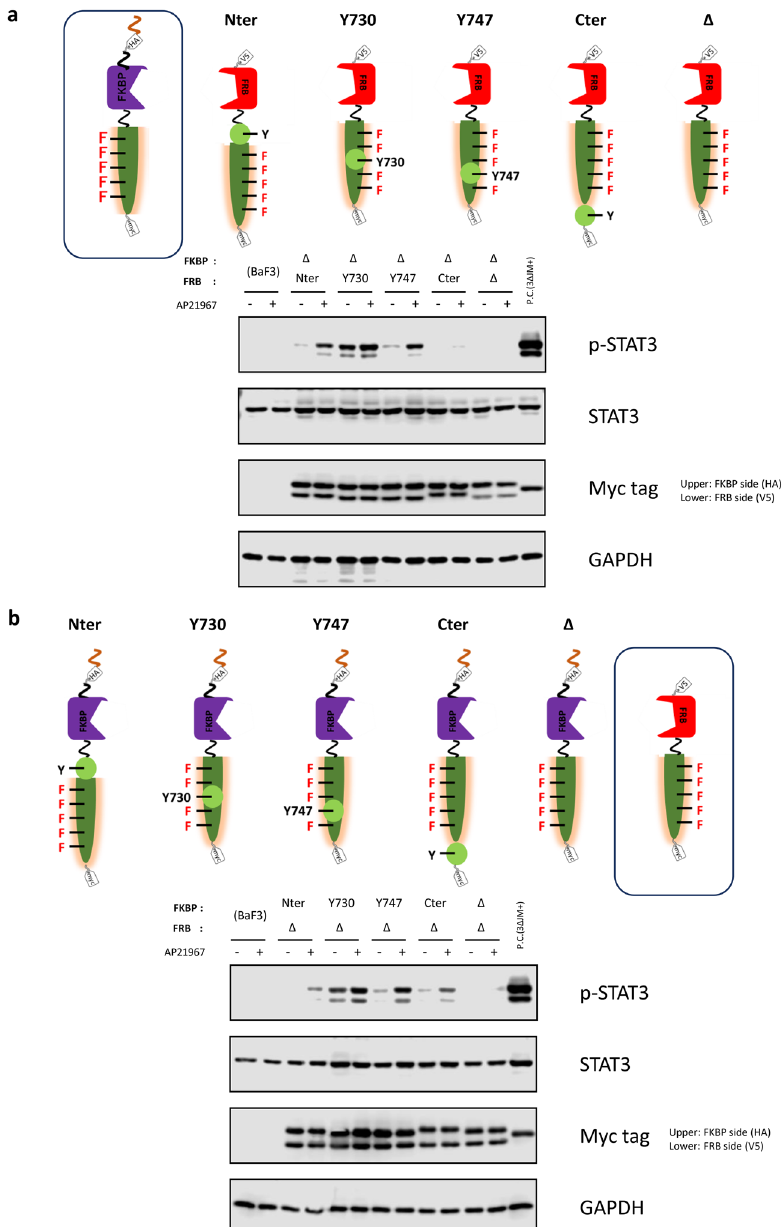
Figure 4. Investigating positional effects for a tyrosine motif. The STAT3-binding motif was positioned at the N-terminus, C-terminus, Y730, or Y747 of the engineered c-KIT of the FRB side ( a ) and FKBP side ( b ) of the chimeras. The symbol Δ means no motif for each position. The positive control (3ΔJM+) is the homodimeric designer receptor, in which the STAT3-binding motif was positioned at the N-terminus of the engineered c-KIT. In western blotting, parental Ba/F3 and the transduced cells were unstimulated (−) or stimulated with 50 nM AP21967 (+). Phospho-STAT3, whole STAT3, myc tag (both FKBP and FRB chimeras; upper and lower bands, respectively), and GAPDH (loading control) were detected using corresponding primary antibodies. Full-length blots are presented in Supplementary Fig.